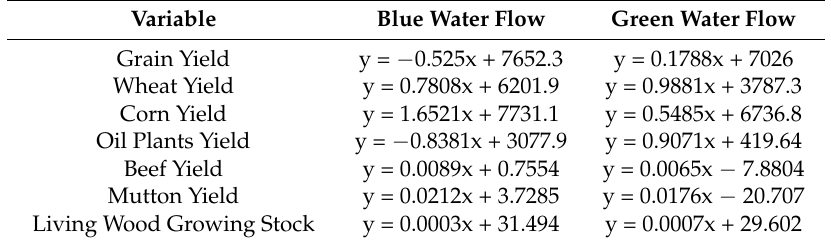
Table 2. Linear regression equations of green and blue water flow for different ecosystem